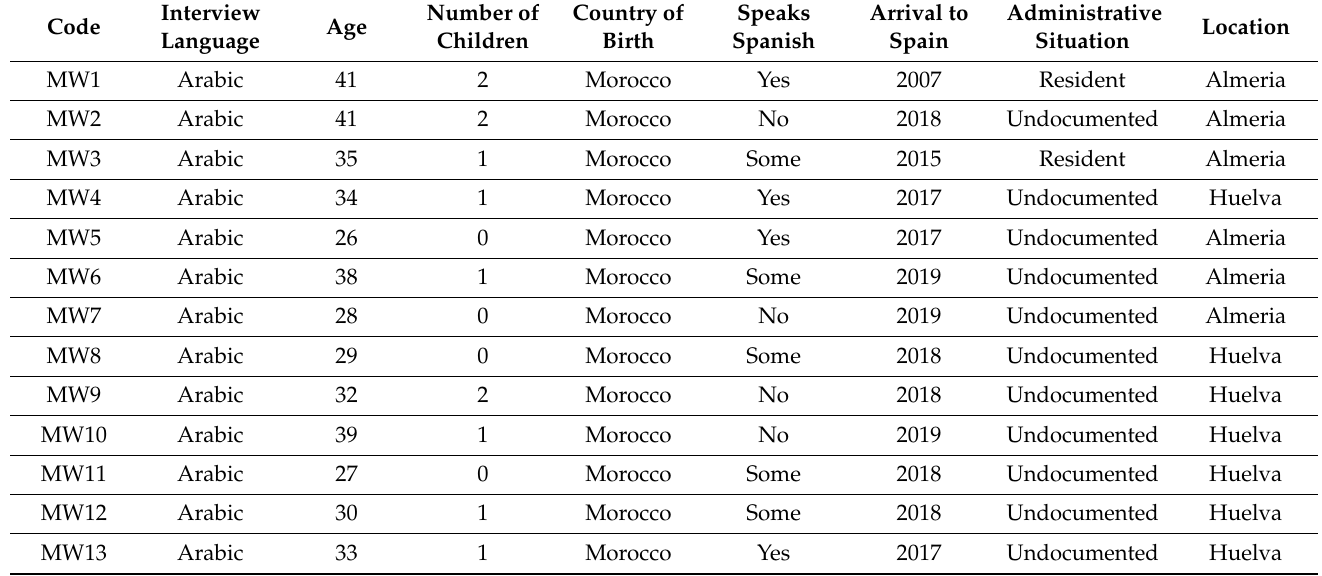
Table 1. Characteristics of the